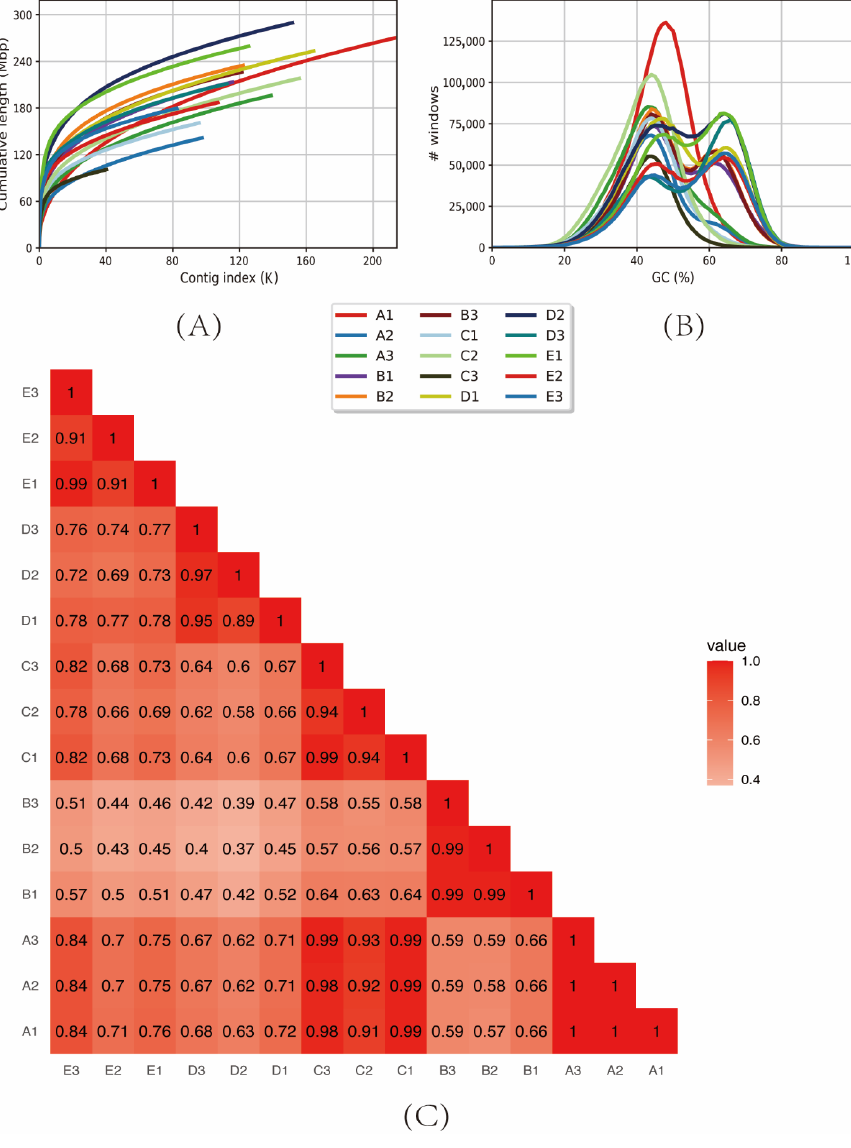
Figure 1. Statistics for the assembly and unigenes. ( A ) The cumulative plot. ( B ) GC content plot. On the x -axis, contigs are ordered from the longest to the shortest. The y -axis shows the cumulative length. ( C ) Sample correlation plot based on the relative abundance of unigenes. Colors show the Pearson correlation coefficient.